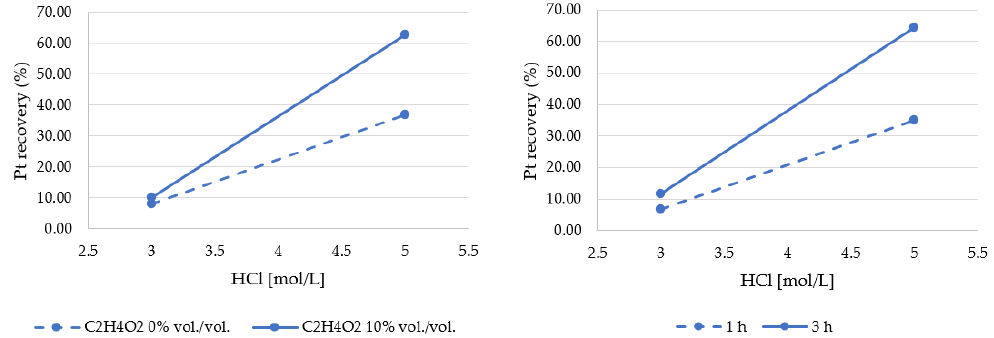
Figure 9. Effects of second-order interactions on the Pt recovery yield.